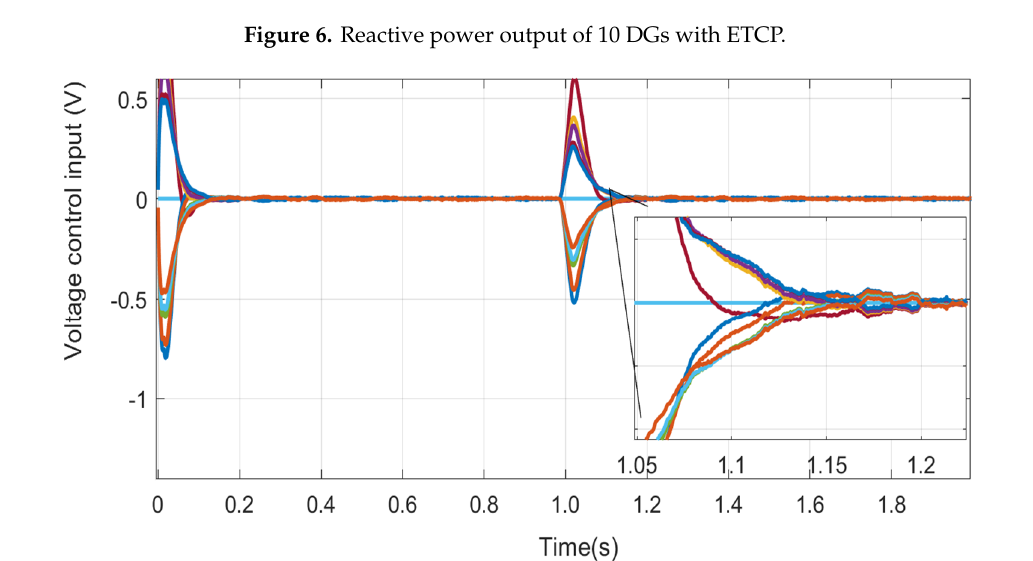
Figure 7. Control input with periodic communication.